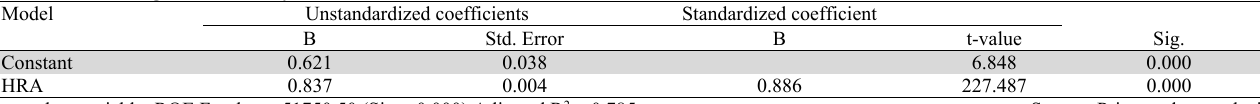
The results of regression analysis